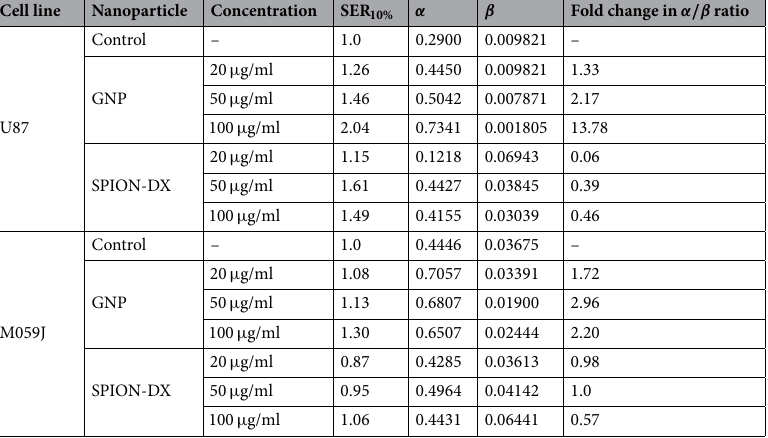
Table 2. Sensitization enhancement ratios calculated at 10% survival (SER 10% ) for cells irradiated by 6 MV photons after being pre-incubated during 24 h with GNPs and SPION-DX at 20, 50 and 100 µ g. Fitting parameters ( α and β ) were calculated based on the LQ model. Fold change in α/β ratio is defined as the ratio of α/β derived from the samples treated with NP to the α/β extracted from control (untreated) samples.